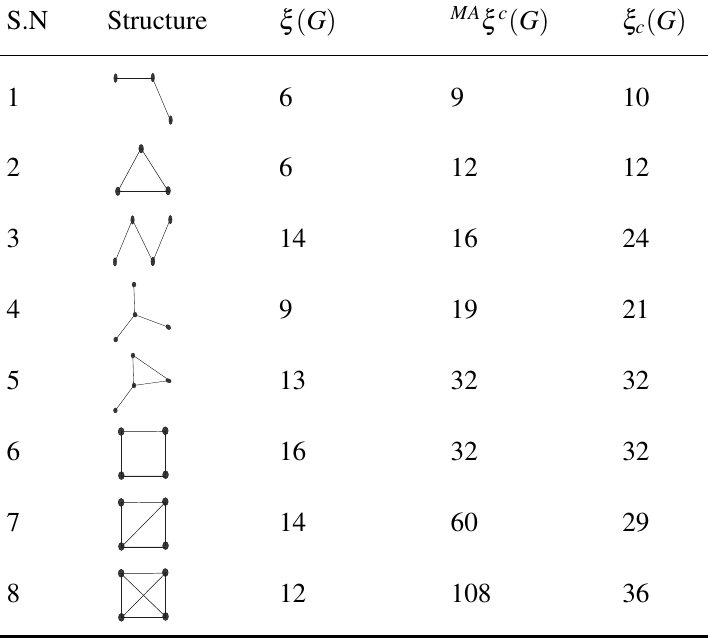
Table 5 Values of eccentric connectivity index, modified eccentric connectivity index and modified augmented eccentric connectivity index for all possible structures with three and